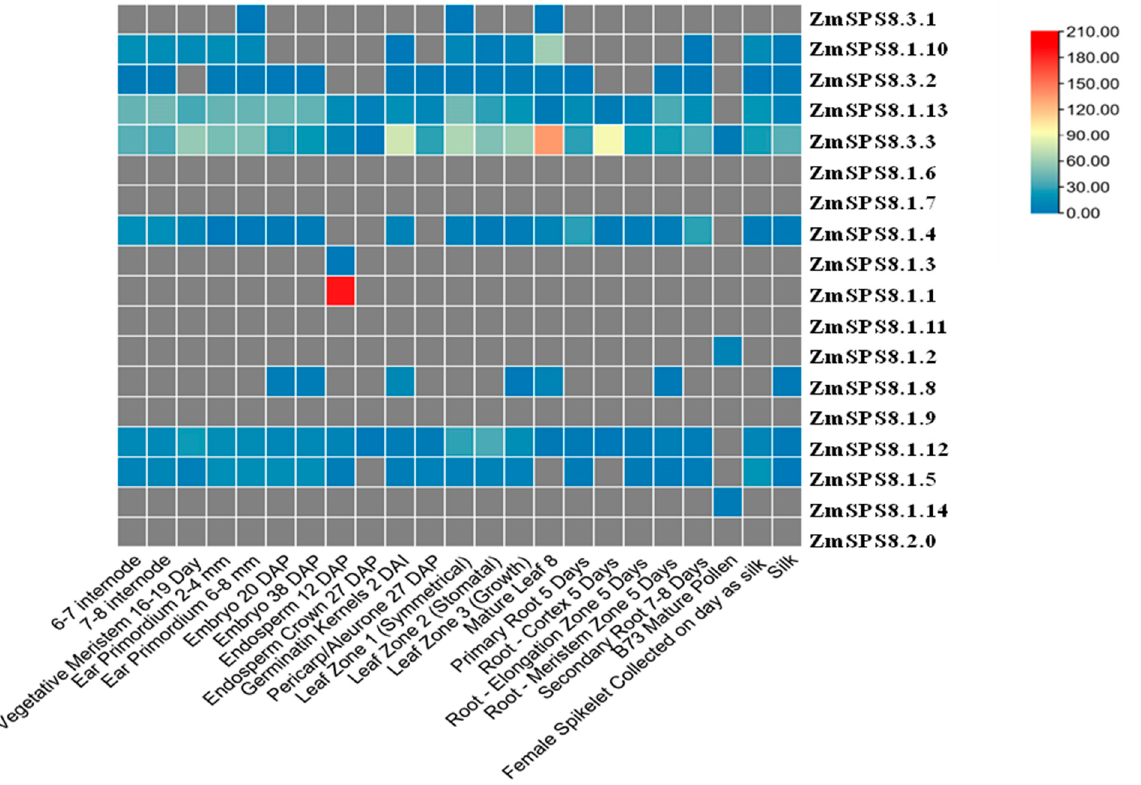
Figure 5. Expression pattern analysis of the maize serine peptidase S8 family genes in different tissues and organs using transcript data. Expression patterns of the 18 genes were investigated in 23 different tissues and organs using publicly transcriptome data. The fragments per kilobase of transcript per million fragments (FPKM) values of all genes were transformed by log2. The red and grey colors represent the higher and lower relative enrichment of the transcript.